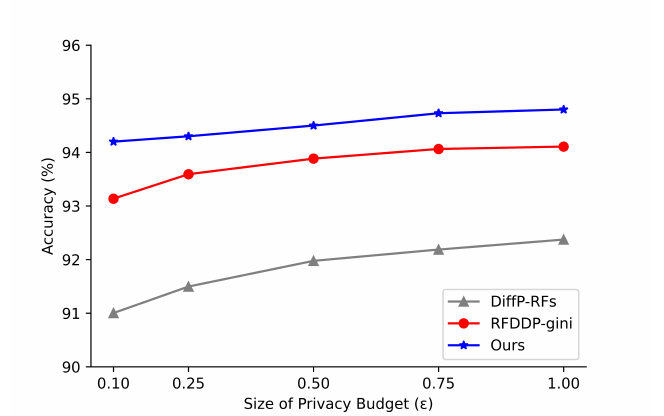
Figure 7. Comparison of classification performance of the three algorithms on Mushroom